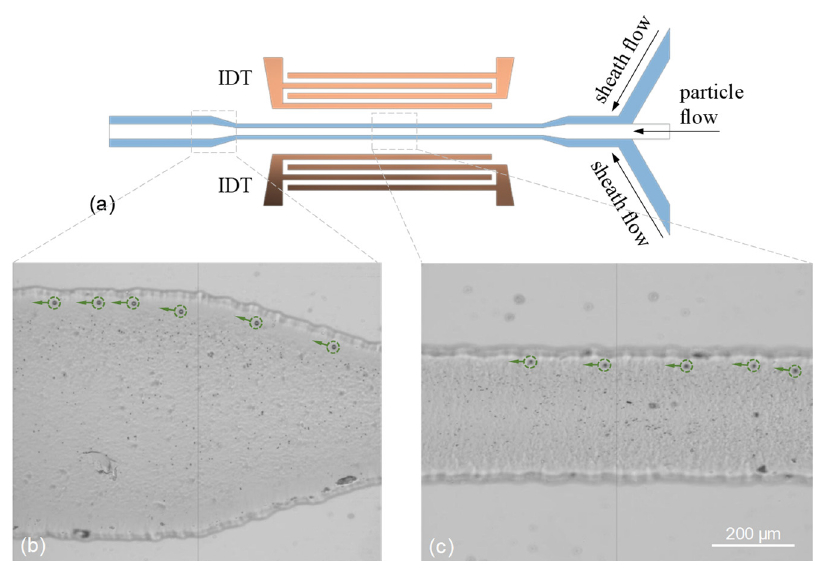
Figure 11. ( a ) Device layout and channel configuration, where the two ends of the channel are designed to expand gradually from 300 to 600 µ m in width. Experimental results of particle separation depicted at the ( b ) expanding region and ( c ) narrow region of the channel by using the standing Lamb waves of the A0 mode. The total volume flow rate is 4 μ L/min, and the used RF power is 32 dBm at the A0-mode frequency.